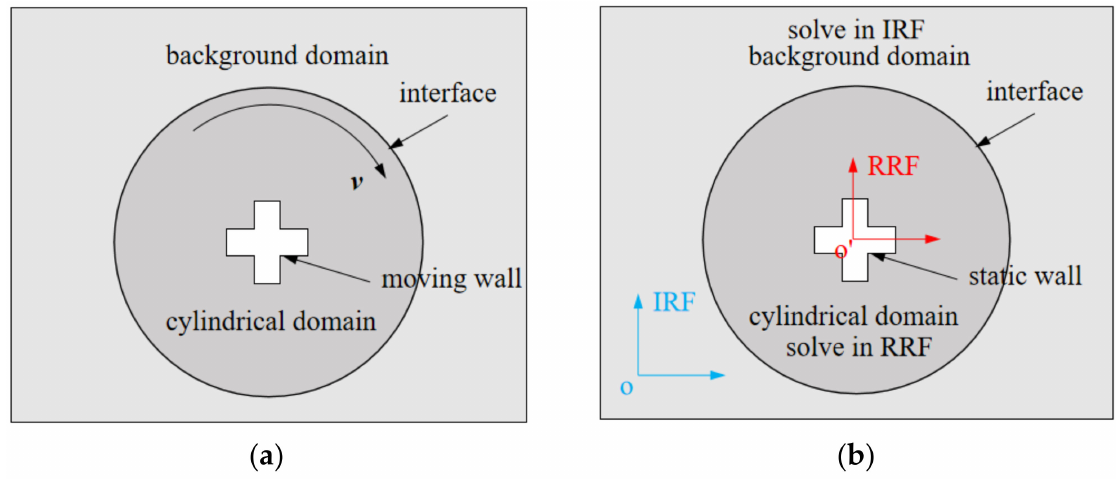
Figure 5. Schematic diagram of SM and MRF methods. ( a ) SM method; ( b ) MRF